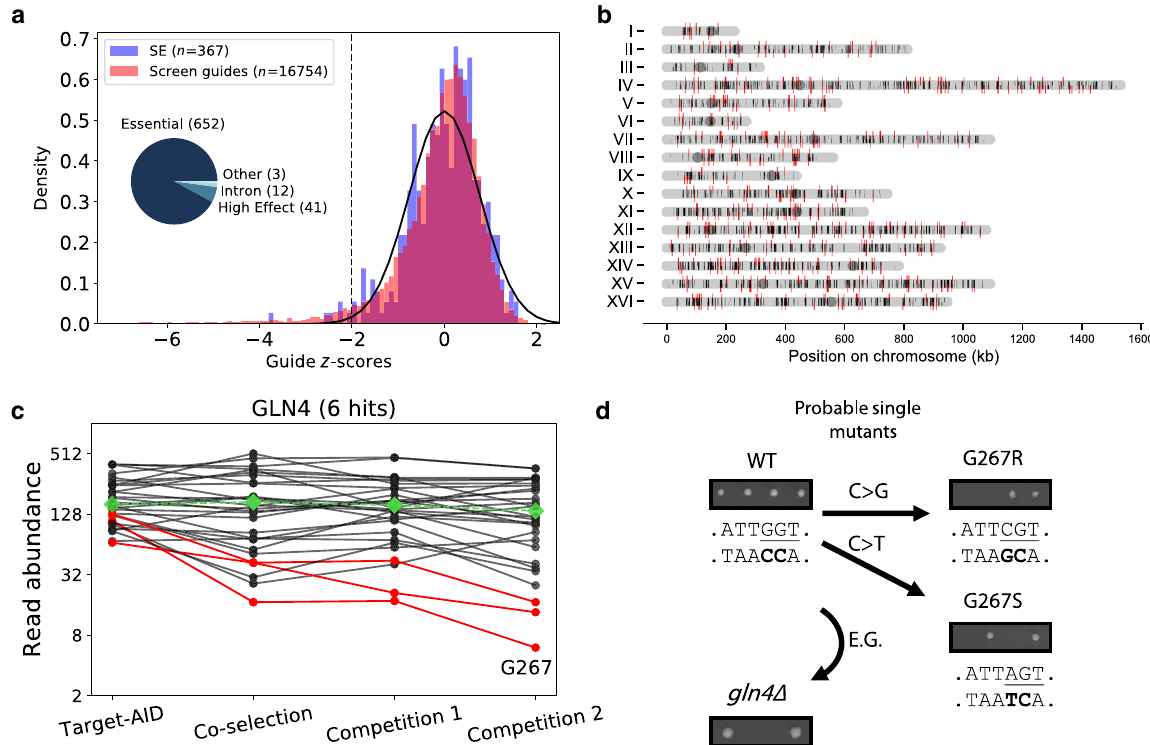
Fig. 3 High-throughput forward mutagenesis by Target-AID base editing identi fi es sensitive sites across the yeast genome. a Cumulative distribution of z-scores of the log2 fold-change in gRNA abundance between mutagenesis and the end of the bulk competition experiment. Scores were calculated using the distribution of abundance variation of gRNAs with synthesis errors (SE). The fi tted normal distribution is shown as a black line, and the 10% FDR threshold as a dotted black line. The distribution of target types in the 708 gRNAs with Negative Effects (GNE) is shown in the inset. b Positions of base editing target sites in the yeast genome. Telomeric regions are depleted in target sites because very few essential genes are located there. GNEs are shown in red, and other gRNAs are in black. The orientation of the line matches the targeted strand relative to the annotated coding sequence. c Average decline in gRNA abundance (on a log scale) between time points ( n = 2 replicates) after mutagenesis for gRNAs targeting GLN4 ( n = 30 gRNAs), a tRNA synthetase. Median gRNA abundance across the entire library over time is shown in green. The red lines represent the gRNAs categorized as having a signi fi cant effect (GNE) for this gene, while non-signi fi cant gRNAs (NSG) are shown in black. The gRNA with the most extreme z-score targets residue G267. d Mutagenesis of Gln4-G267 validates its essential role for protein function. Tetrad dissection of a heterozygous deletion mutant bearing an empty vector results in only two viable spores, while the wild-type copy in the same vector restores growth. Dissection of the two heterozygous mutants bearing a plasmid with the most probable single mutant based on the known activity window of Target-AID shows both mutations are lethal. Source data are available in the Source Data fi large-scale saturated mutagenesis data of multiple proteins to qualitative values. Mutations with a low SIFT score have a lower perform quantitative predictions of missense mutation effects on chance of being tolerated, while those with a positive ΔΔ G are protein function. The lower the Envision score, the higher the predicted to destabilize protein structure or interactions. Both predicted effect on protein function. Mutfunc aggregates multiple Envision and the Mutfunc aggregated SIFT data cover the types of information such as residue conservation through the use majority of the most probable mutations generated by the gRNA of SIFT 32 as well as structural constraints to provide a binary library (Supplementary Fig. 12A). The structural modeling prediction of variant effect based on multiple quantitative and information had much lower coverage, covering at best around